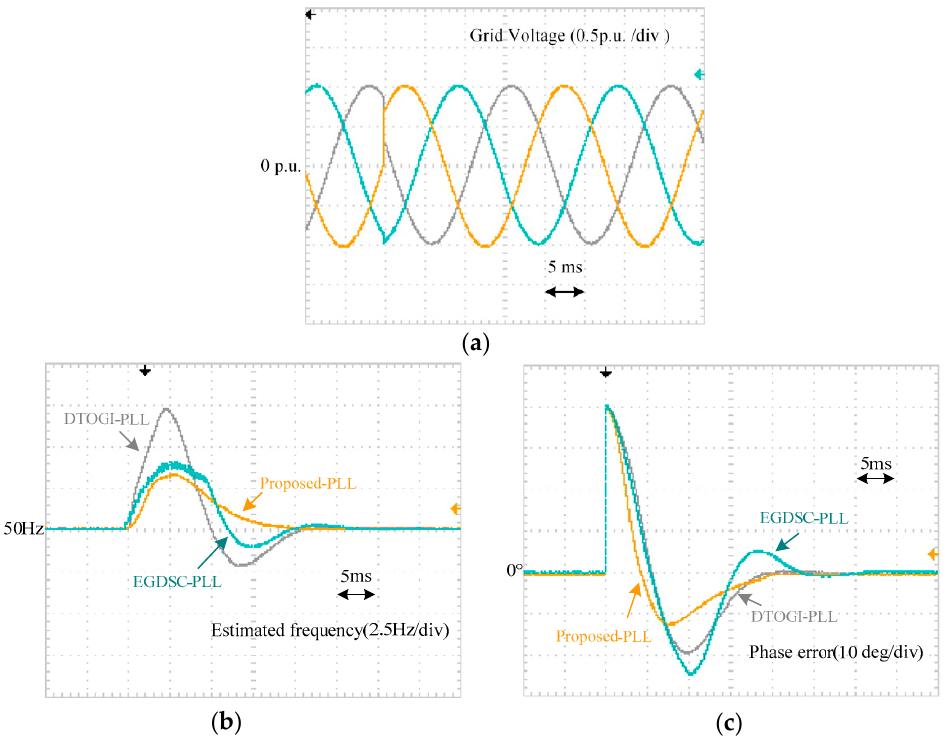
Figure 16. Experimental waveforms when the grid voltage undergoes a phase jump of +40. ( a ) is the grid voltage waveform, ( b ) is the estimated frequency waveform, and ( c ) is the phase error waveform.